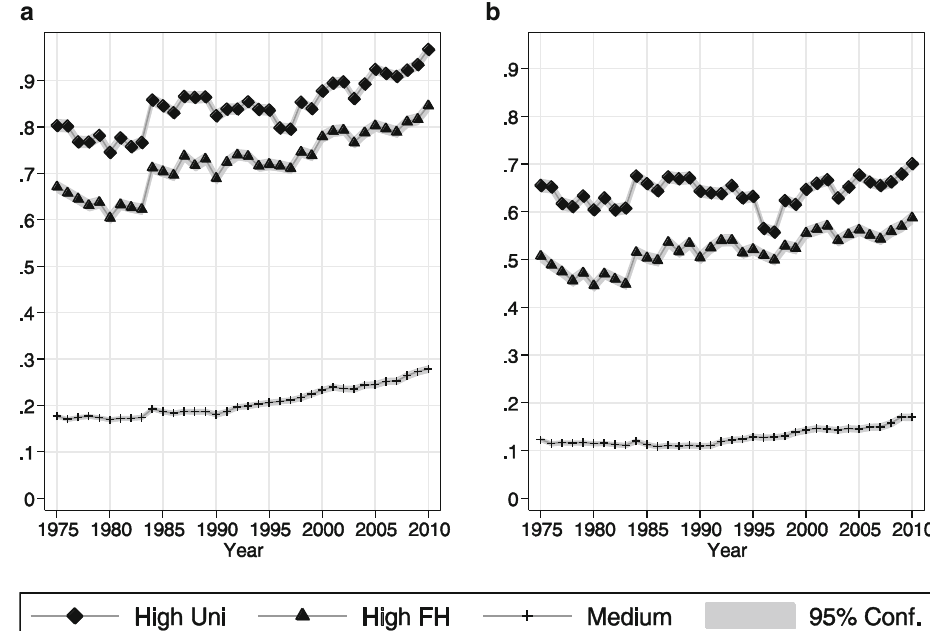
Fig. 6 Wage Premia for Edu- cation Groups (25 to 35 years) (Source: 2% IABS Sample for full-time workers between the age of 25 and 35 years. Left panel : N = 6,738,035. Right panel: 6,569,463. Note: Wage premia are indicated by coeffi- cients obtained from year-by- year estimations of Mincer earn- ings equations with education attainment (in reference to low education), potential experience, potential experience squared and a female dummy variable ( left panel ), and task categories in addition ( right panel ). All coef- ficients plotted are statistically significant at the 1% confidence level. Wages above the social security contributions ceiling (right-censoring) have been